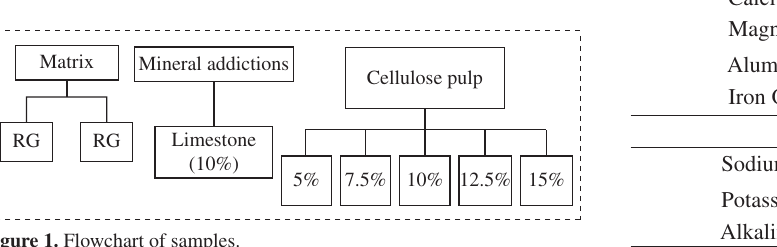
Figure 1. Flowchart of